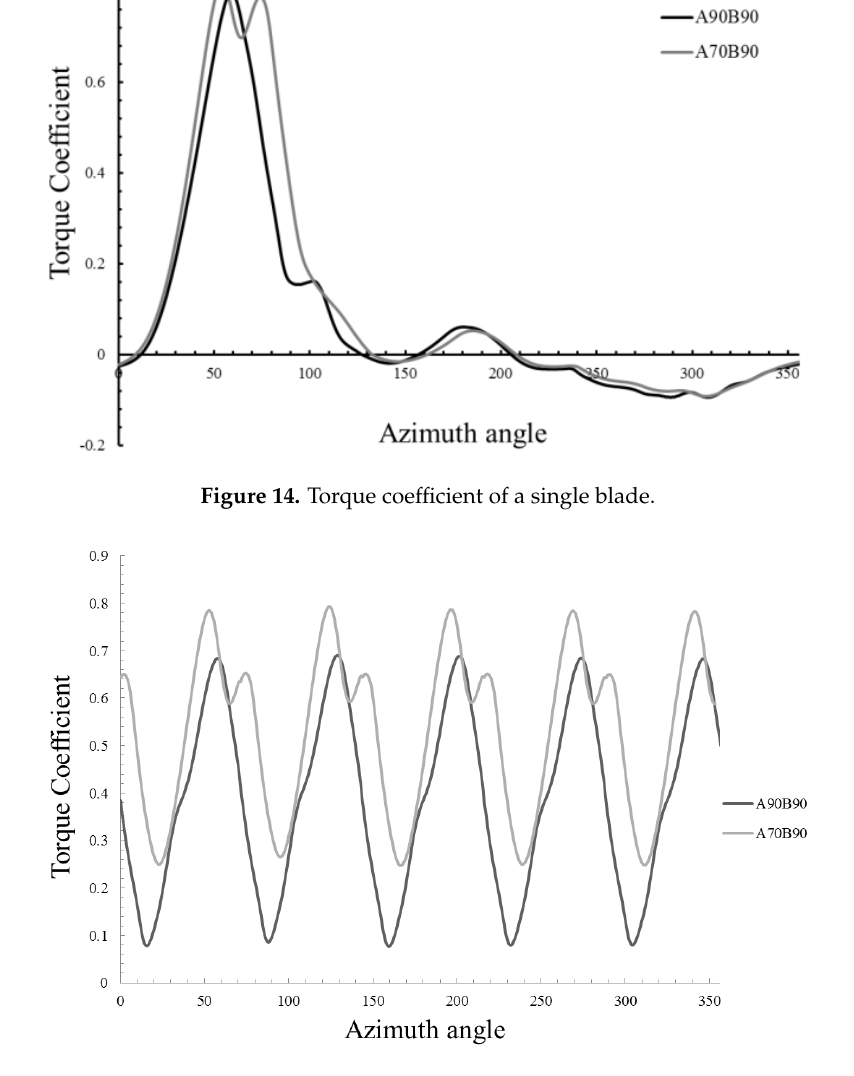
Figure 16. Pressure coefficient contour. ( a ) β = 90° and ( b ) β = 70°.